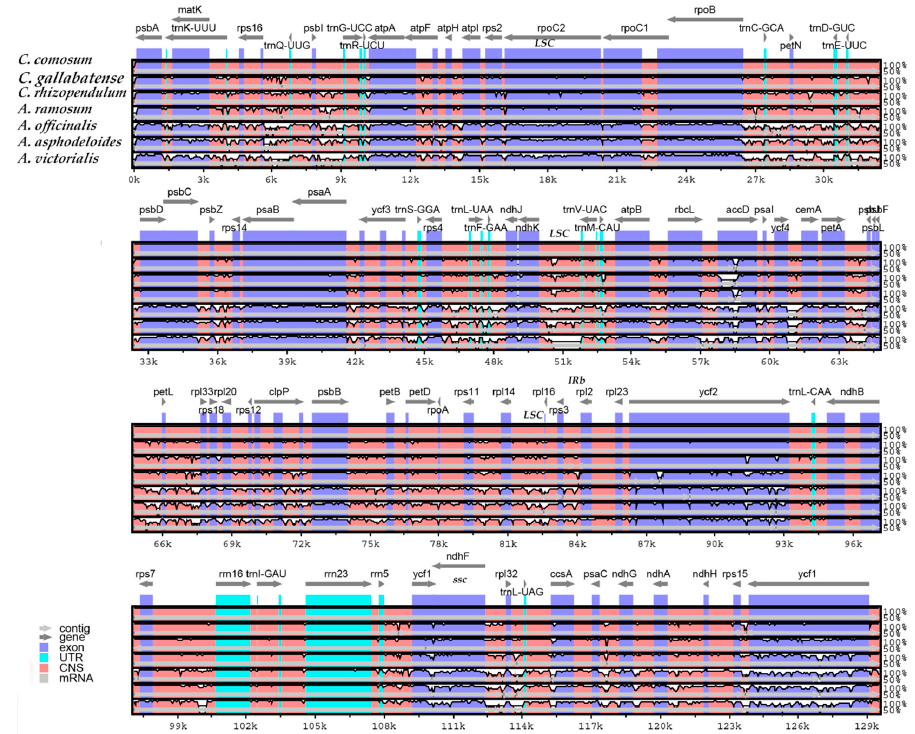
Figure 7. Comparison of seven cp genomes using mVISTA alignment program. Genome regions are color-coded as protein-coding, rRNA coding, tRNA coding, or conserved non-coding sequences. The vertical scale shows the percentage of identity, varying from 50% to 100%.